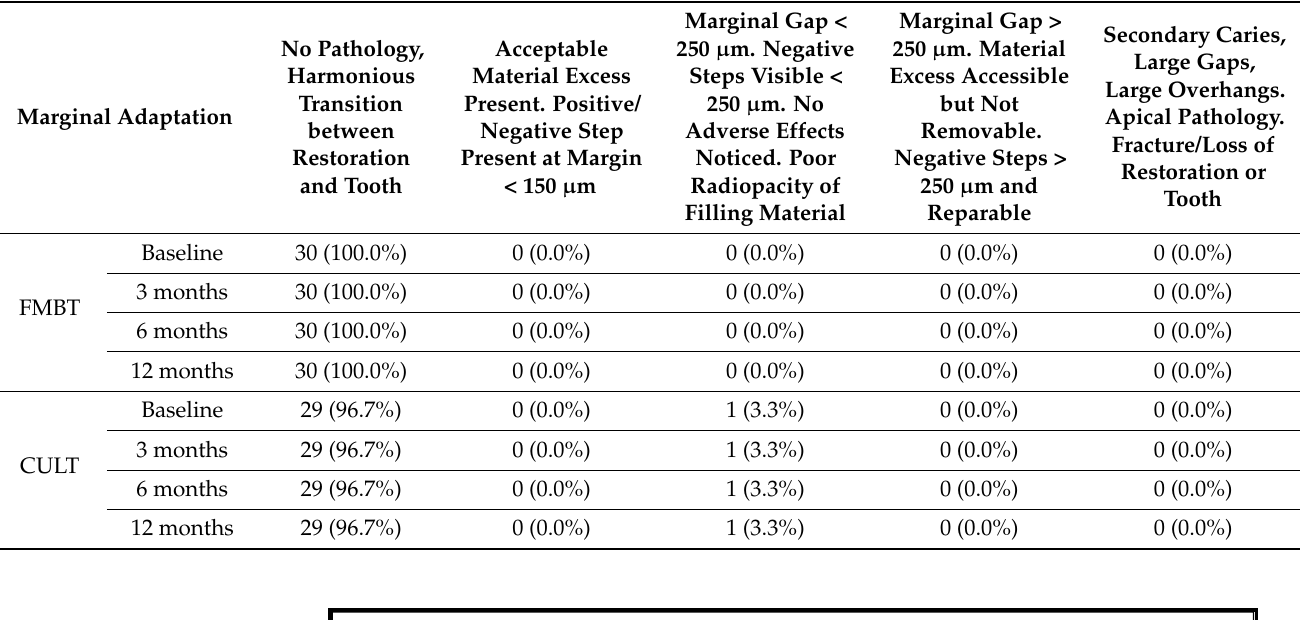
Table 7. Marginal adaptation of teeth restored with FMBT and CULT over time ( p > 0.05).